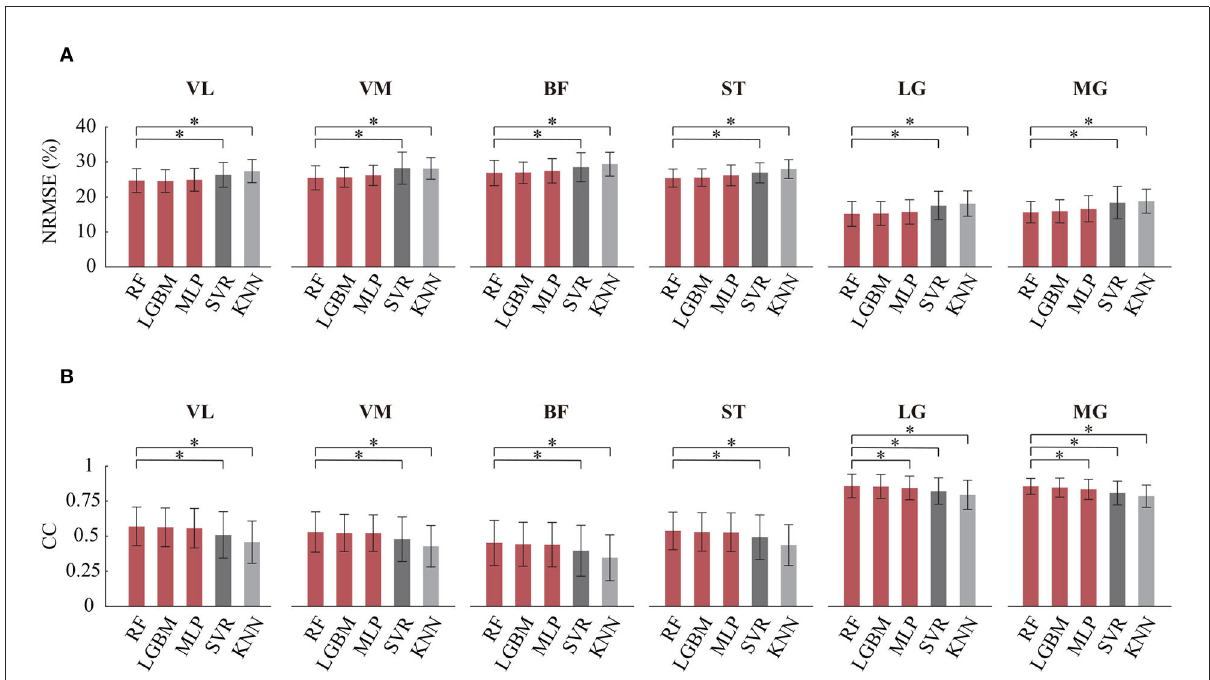
FIGURE6 Comparison of angle estimation accuracy on different regression models. RF, random forest regression; LGBM, gradient boosting machine; MLP, multilayer perceptron (MLP); SVR, support vector regression; KNN, k-nearest neighbors regression. (A) Comparison of NRMSE. (B) Comparison of CC. Bars are means, error bars are standard error of the mean (SEM), and asterisks denote statistically significant differences with respect to the RF ( P <